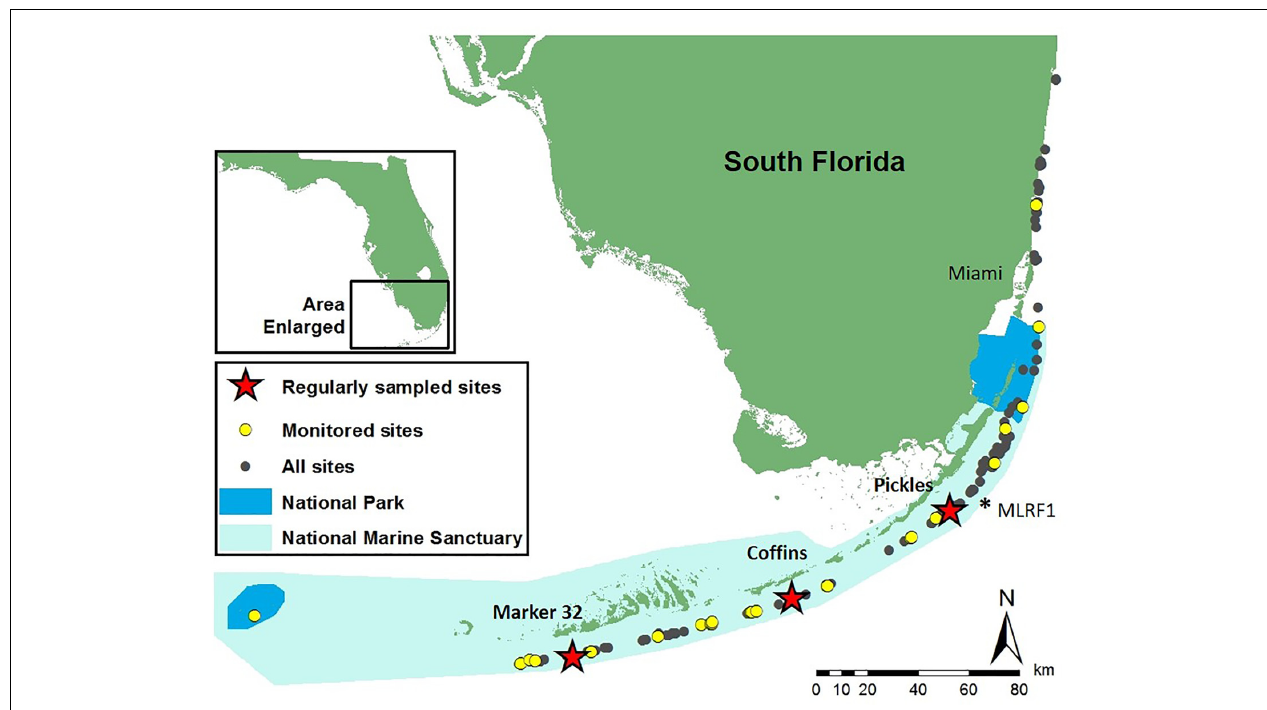
FIGURE 2 | Study sites on the Florida Reef Tract where monitoring and sampling was conducted on the Pillar Coral Dendrogyra cylindrus . Geographically stratified tri-annual monitoring and sampling occurred at 28 sites April 2014 to April 2016 (yellow circles). Pickles (Upper Keys), Coffins (Middle Keys), and Marker 32 (Lower Keys) sites (red stars) were monitored and sampled monthly during bleaching recovery in 2014 and 2015. ∗ MLRF1 – location of Molasses Reef C-man buoy used to calculate 10-year mean monthly